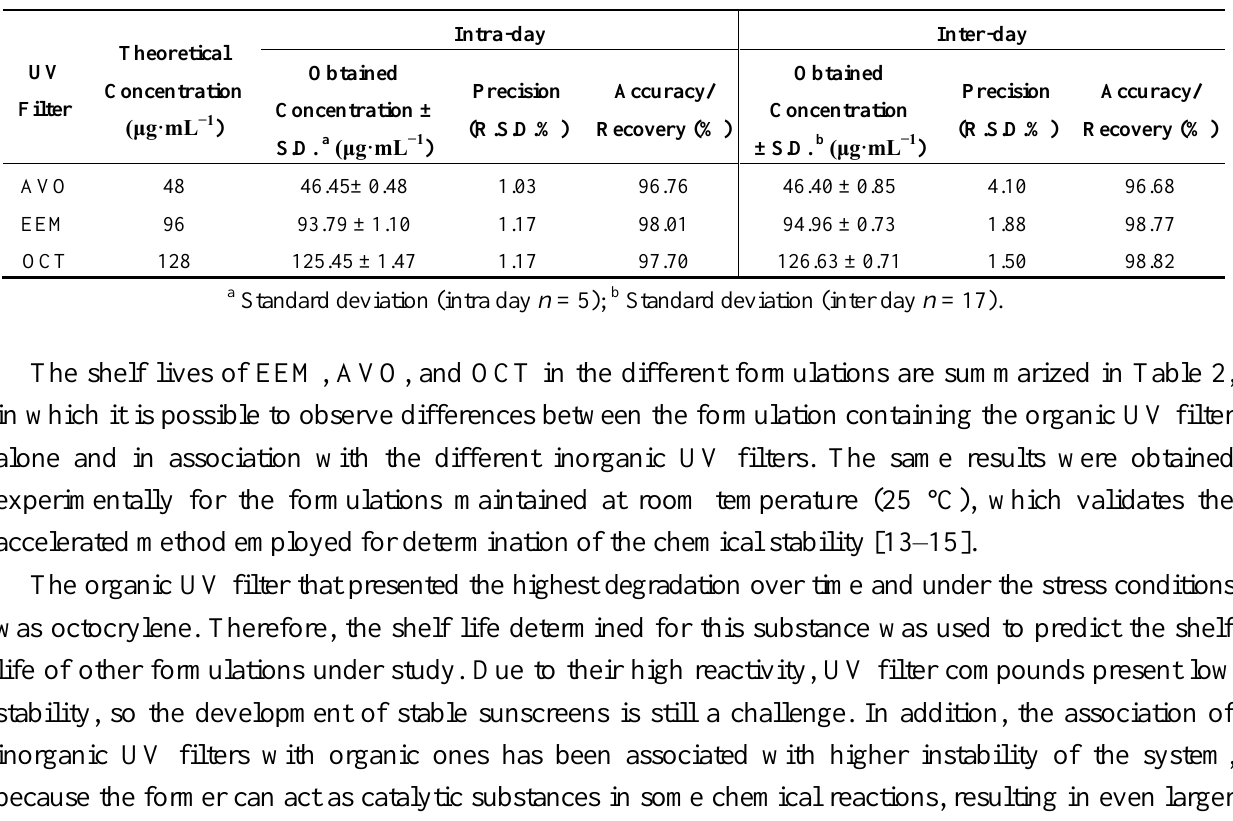
Table 2. Intra- and inter-day precision and accuracy/recovery (%) during the quantification of avobenzone, ethylhexyl methoxycinnamate and octocrylene extracted from experimental